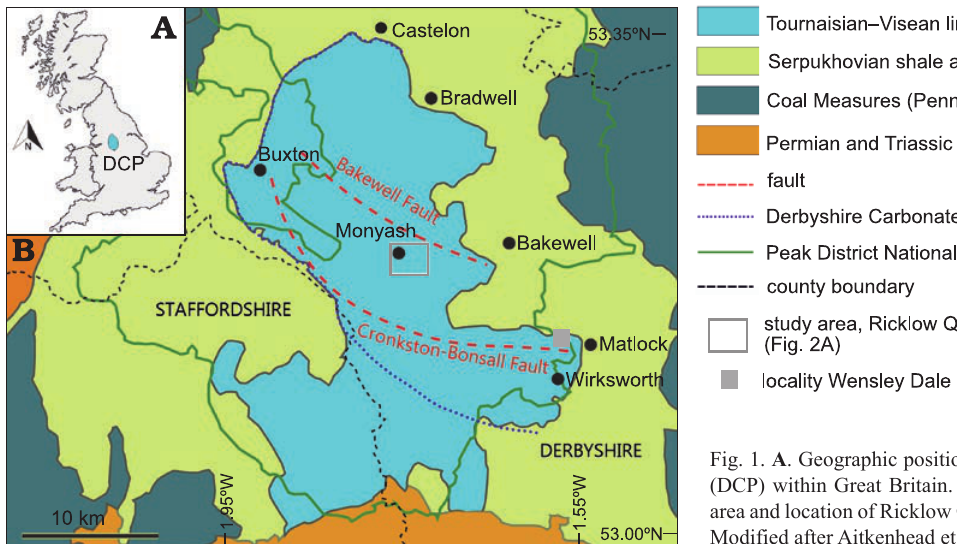
Fig. 1. A . Geographic position of the Derbyshire Carbonate Platform (DCP) within Great Britain. B . Geological map of the Peak District area and location of Ricklow Quarry near Monyash and Wensley Dale. Modified after Aitkenhead et al.